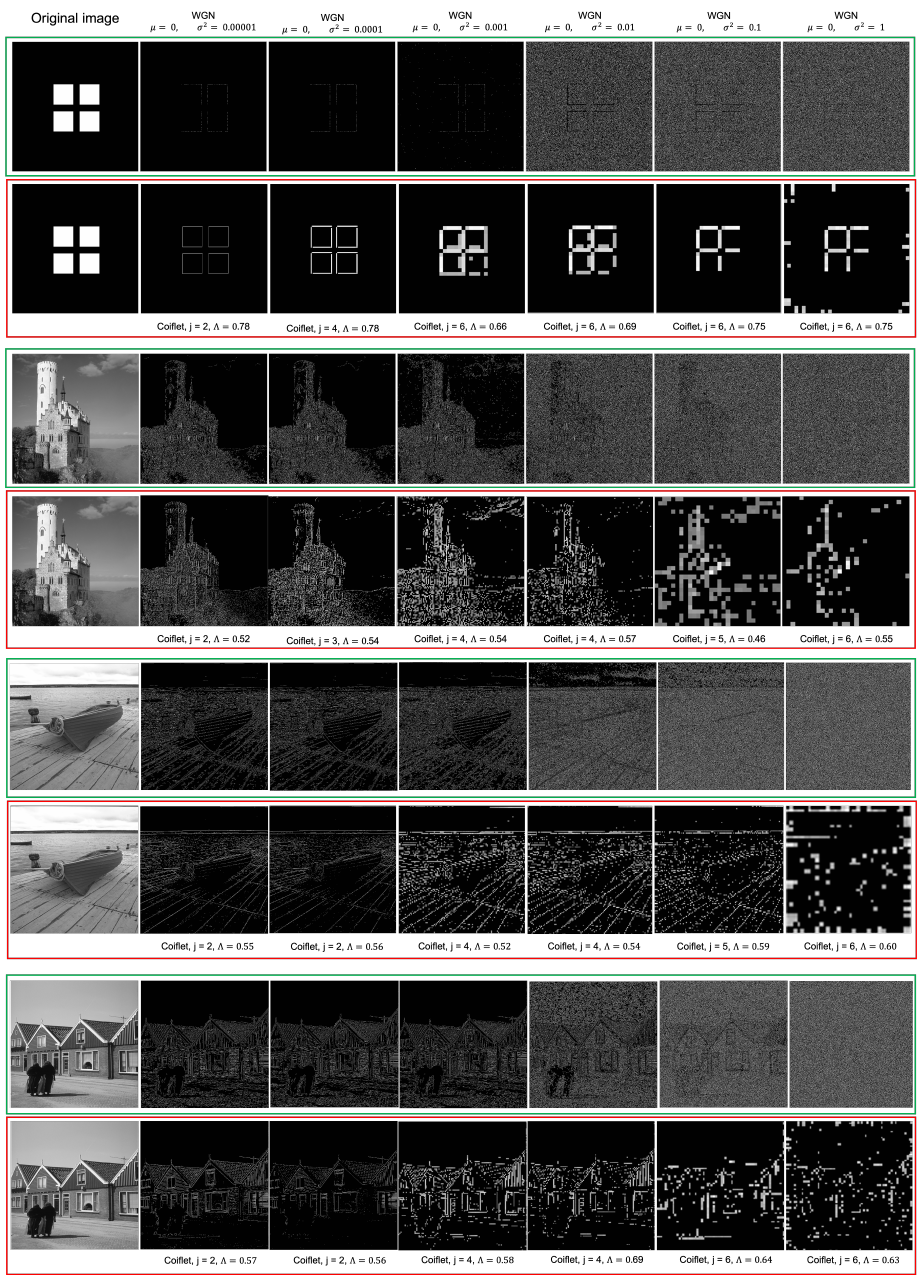
Figure 11. The original image is shown in the first column of the image grid. Other columns correspond to different noise levels. The first, third, fifth, and seventh rows correspond to Canny processed images (grouped in green) and the second, fourth, sixth and eighth rows correspond to LRWEEDA processed images (grouped in red). The corresponding LRWEEDA parameters are shown below the images of red groups. The LRWEEDA processed output images sizes are 483 × 483 pixels when j = 2; 244 × 244 pixels when j = 3; 124 × 124 pixels when j = 4; 64 × 64 pixels when j = 5 and 34 × 34 pixels when j =